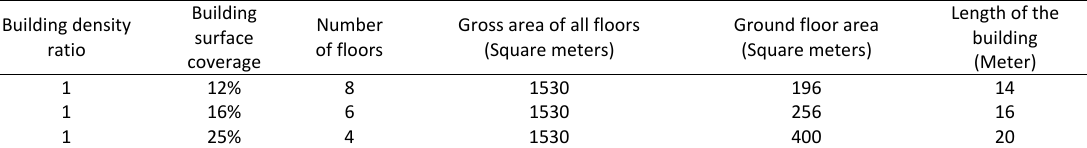
Table 2: Proposed classes for optimizing energy consumption for compact block castings in Khorramshahr Building density ratio